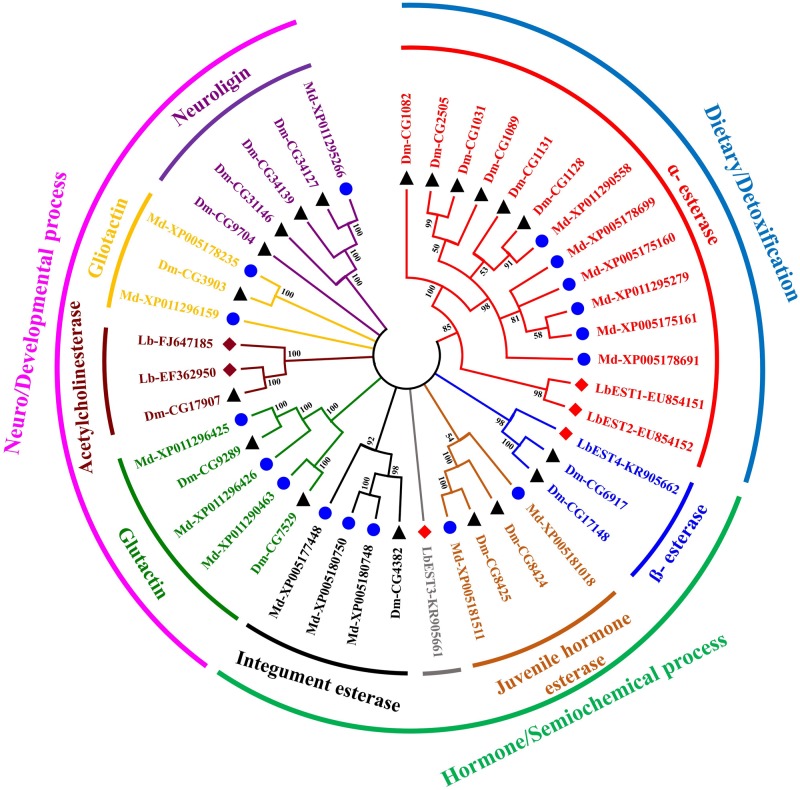
An un-rooted Neighbor-joining tree constructed based on the esterase amino acid sequences from Liposcelis bostrychophila and other insects. Esterase genes from L. bostrychophila (Lb), Musca domestica (Md), and Drosophila melanogaster (Dm) are marked by filled rhombus (red color indicates for esterases; brown color indicates for acetylcholinesterases), blue filled circle and black filled triangle, respectively. Different clades are shown in different colors. Nodes with >50% bootstrap values are shown. All insect esterase sequences were retrieved from NCBI.